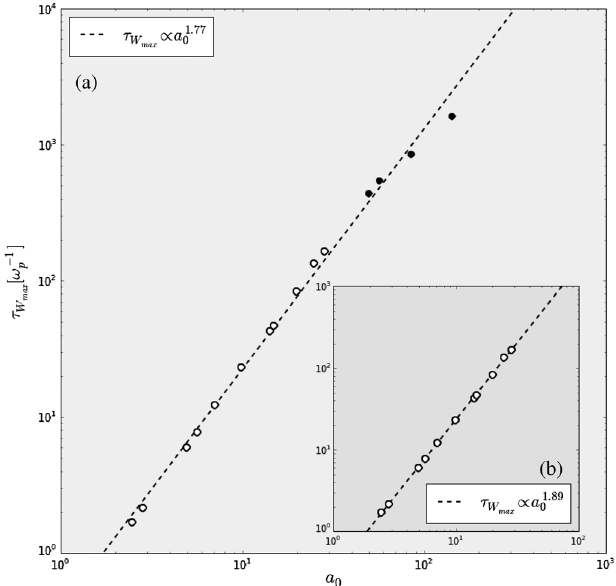
FIG. 4. Log-log plot of time to reach the max kinetic energy against intensity a 0 for a positronlike mass ratio. (a) This scaling contains all of the relativistic data points ( a 0 > 1 ). (b) This scaling contains points in the region where a 0 is relativistic, but finite grid effects have a negligible contribution.